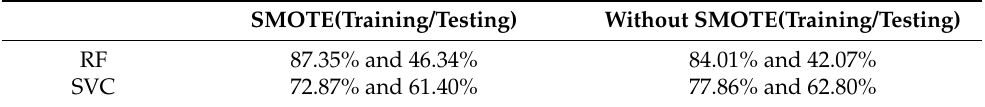
Table 10. Multiclass classification accuracy (23 features).